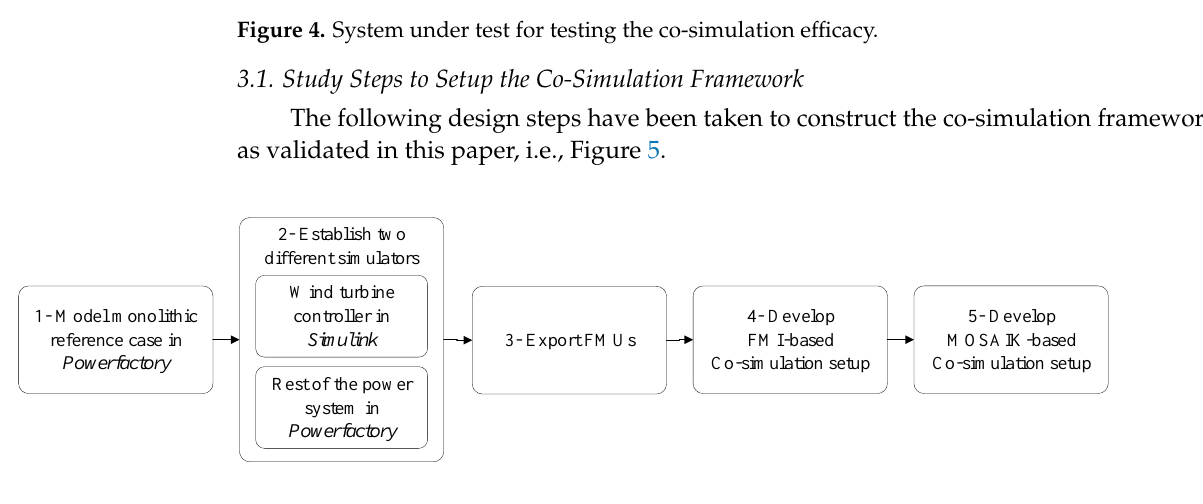
Figure 5. Overview of design steps for the proposed co-simulation